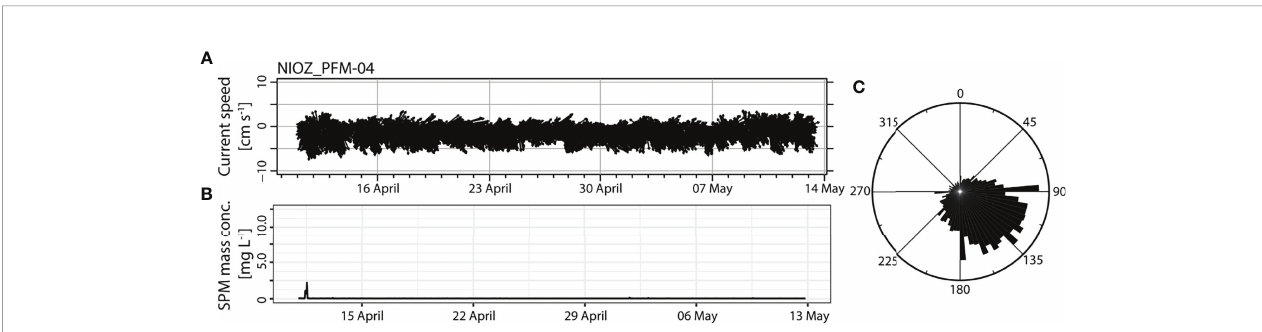
FIGURE 9 | Longer-term variability of current speed and direction and SPM concentration at sensor platform NIOZ_PFM-04, recorded between the 11 th of April and the 13 th of May 2019, 200 m south of the dredge tracks. (A) Current speed and direction, showing predominant southeast current direction, alternating with northerly direction. (B) Recorded SPM mass concentrations during the entire deployment period. (C) Rose diagram display of the recorded current